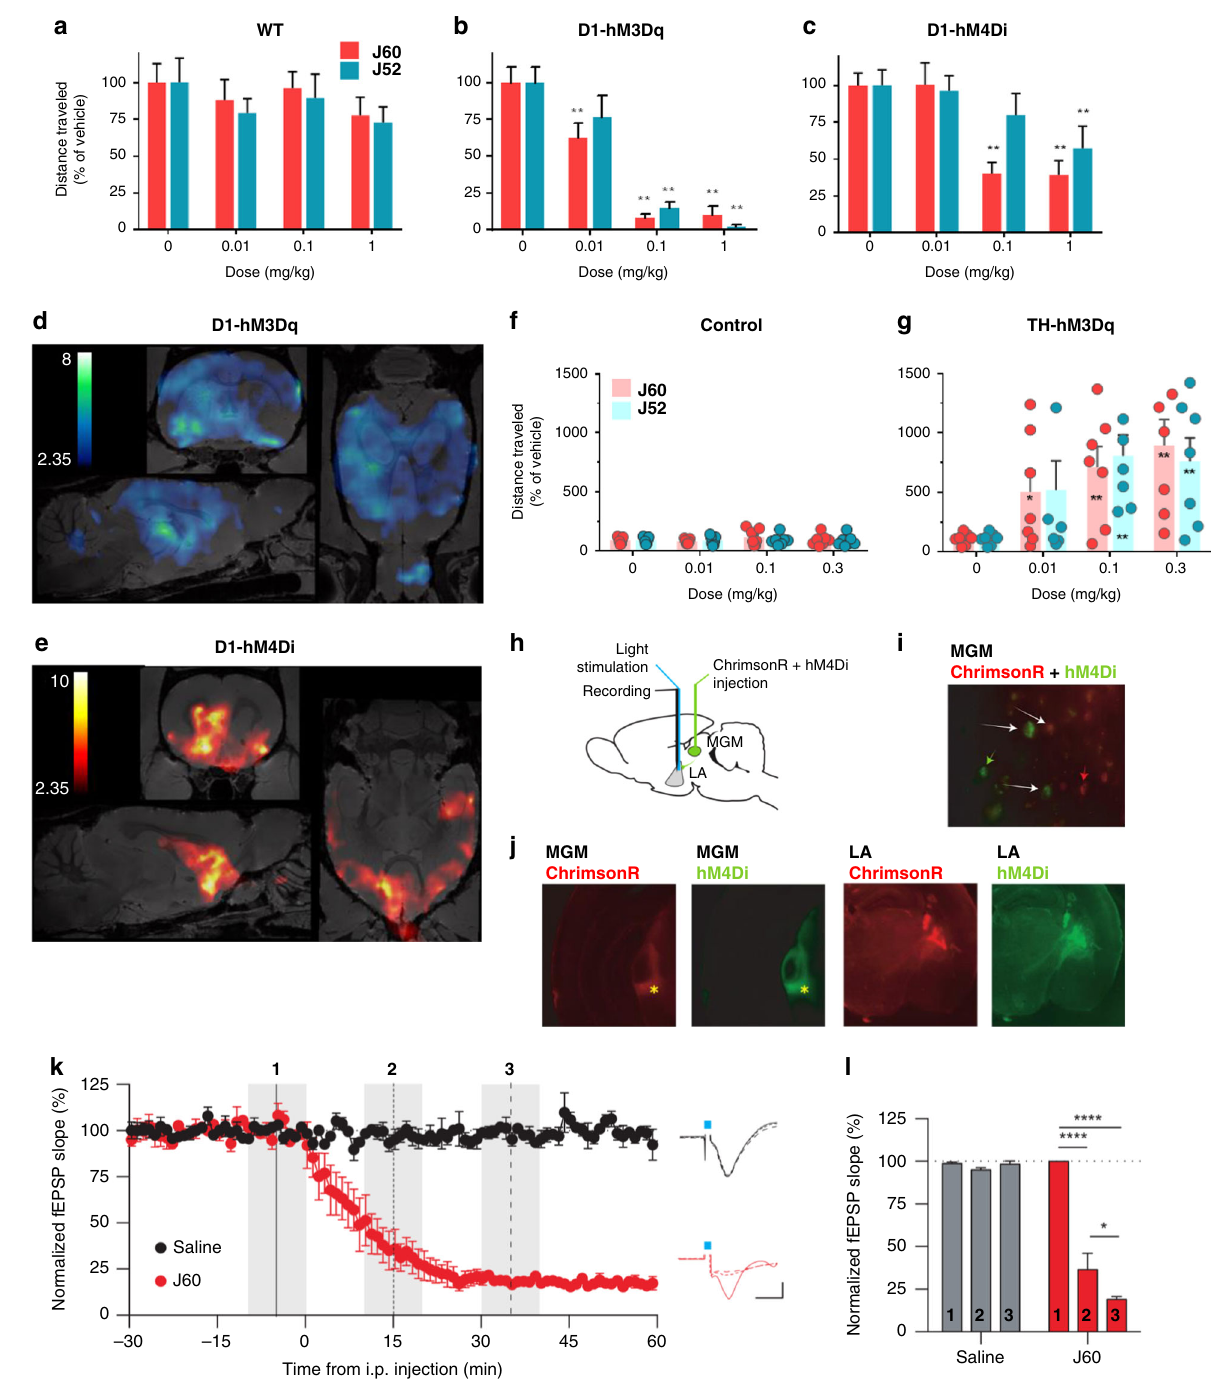
Fig. 3 JHU37152 and JHU37160 exhibit high in vivo DREADD potency. a – c J60 and J52 produce potent inhibition of locomotor activity in transgenic D1- DREADD mice but not in wild-type (WT) mice ( n = 7 to 19 mice per condition). Two-way repeated measures ANOVA followed by Dunnett ’ s multiple comparison tests were performed, * p < 0.05 and ** p < 0.01 compared with the respective vehicle. d, e DREADD-assisted metabolic mapping (DREAMM) using [ 18 F]FDG in D1-hM3Dq and D1-hM4Di mice ( n = 4 mice per condition) reveals opposing and differential recruitment of whole-brain functional networks. f , g J52 and J60 produce potent activation of locomotor activity in rats ( n = 7 rats per condition) expressing hM3Dq in tyrosine hydroxylase (TH)-expressing neurons in the ventral tegmental area. One-way repeated measures ANOVA followed by Dunnett ’ s multiple comparison tests were performed, * p < 0.05 and ** p < 0.01 compared with the respective vehicle. h – j Design of in vivo electrophysiological experiment and IHC showing hM4Di (green) and ChrimsonR (red) expression in the medial division of the medial geniculate nucleus (MGM) and lateral amygdala (LA). k , l J60 (0.1 mg kg − 1 ) produces rapid and potent hM4Di-driven inhibition of light-evoked neuronal activation. Data are represented as mean ± SEM, * p < 0.05, *** p < 0.001. Source data are provided as a Source Data fi